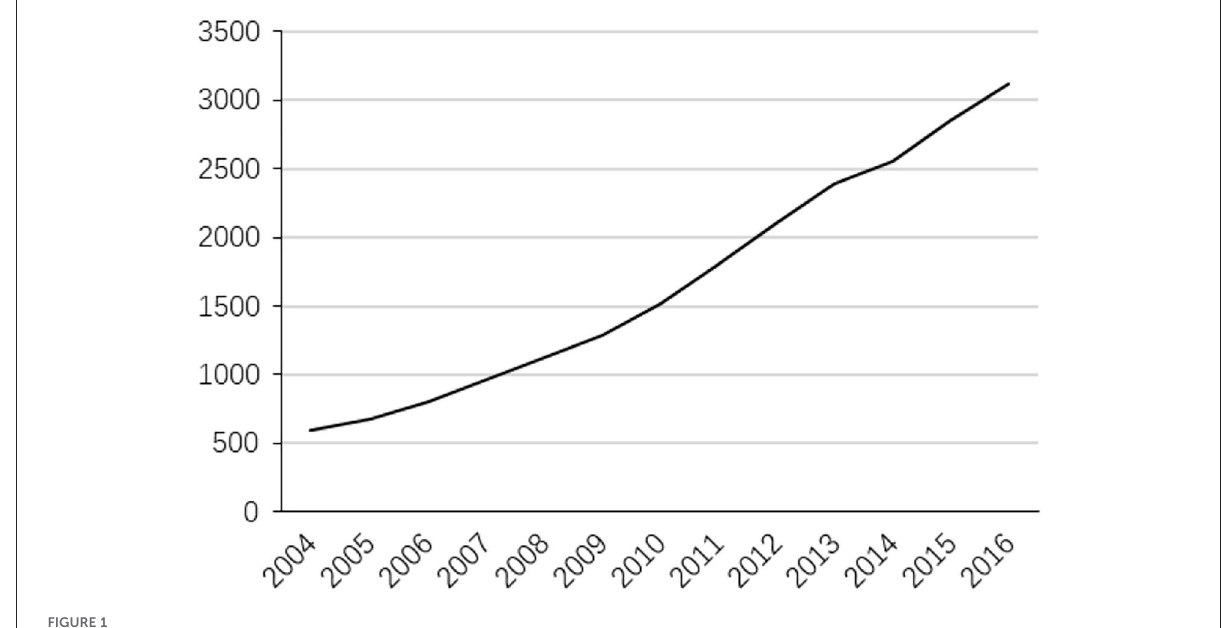
FIGURE1 Environmental regulation dividends.